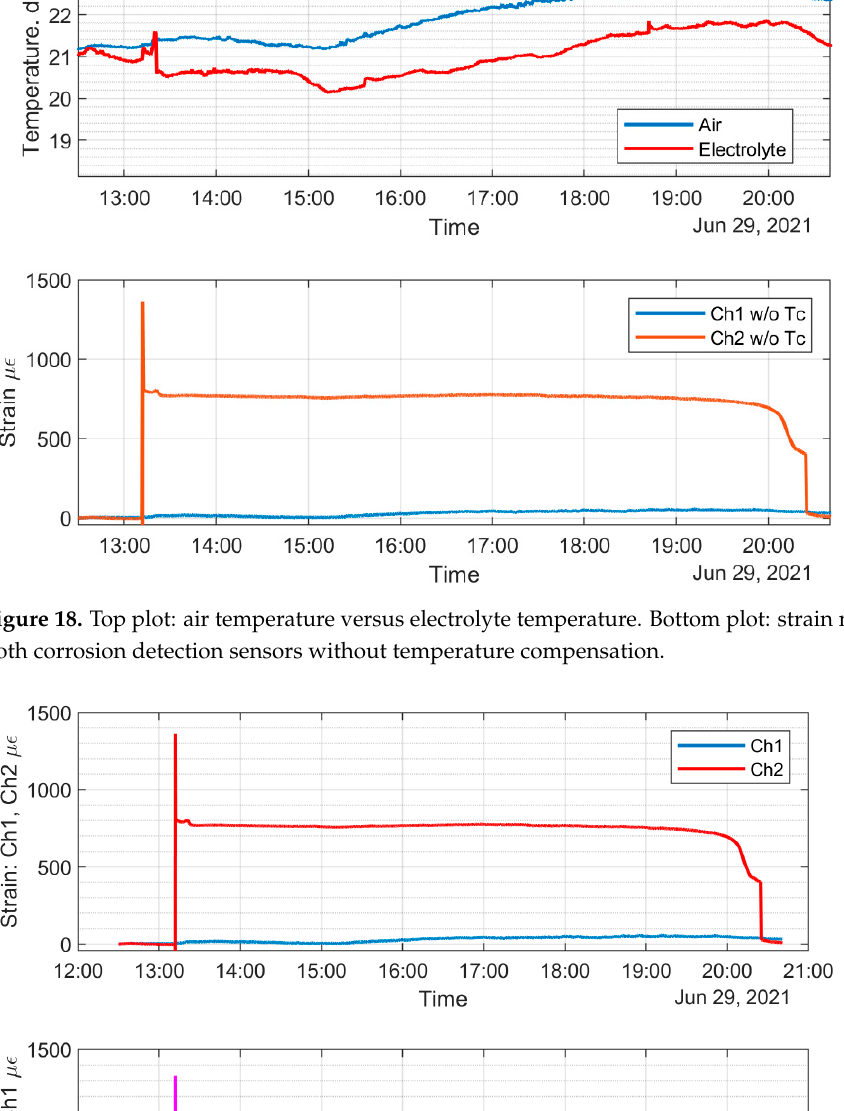
Figure 18. Top plot: air temperature versus electrolyte temperature. Bottom plot: strain measured on both corrosion detection sensors without temperature compensation.